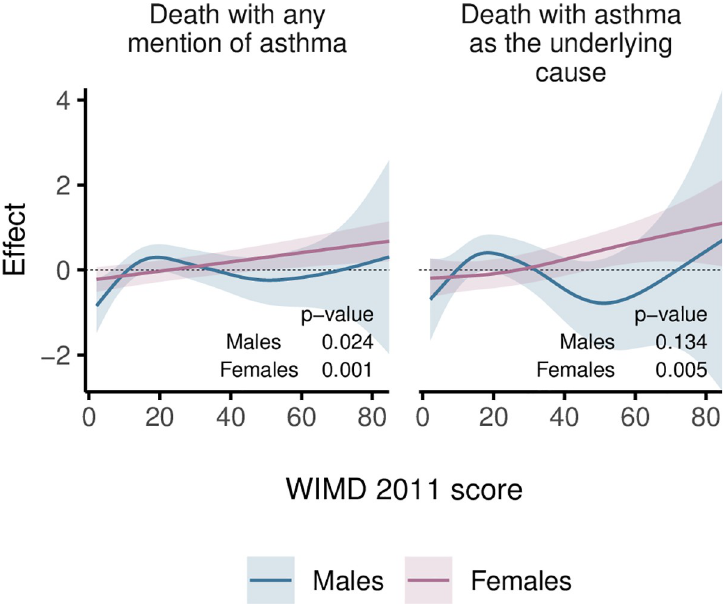
Fig 10. Smooths from GAMs showing the association of the WIMD 2011 score on asthma death in males and females. The shaded area represents the 95% CI of effect. CI, confidence interval; GAM, generalised additive model; WIMD, Welsh Index of Multiple Deprivation.